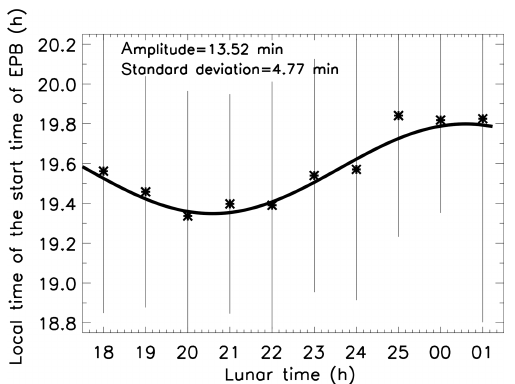
Figure 4. Lunar semidiurnal M 2 fit (solid line) to the start times of EPBs observed from the airglow images. The error bars are the standard deviation of the data within each hourly